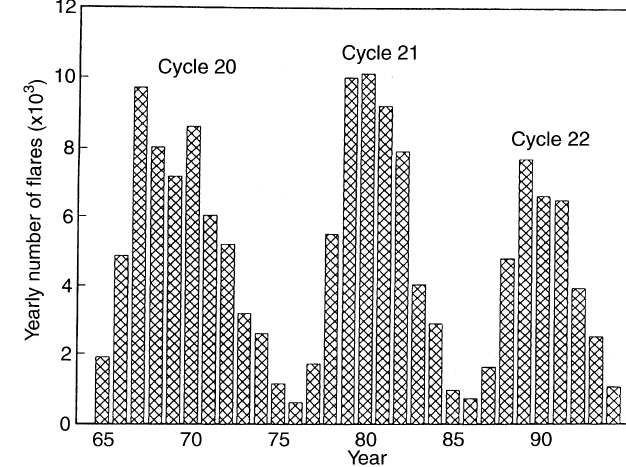
Fig. 3. Annual number of grouped (active region) solar flares from 1965 to 1994 taken from Solar